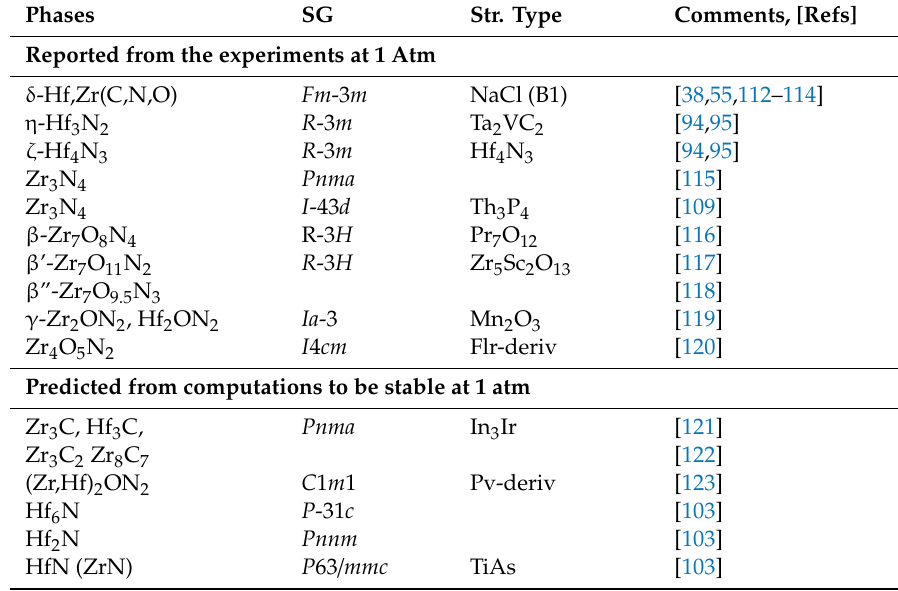
Table 1. Phases reported and predicted in Hf-C-N-O and Zr-C-N-O systems at ambient